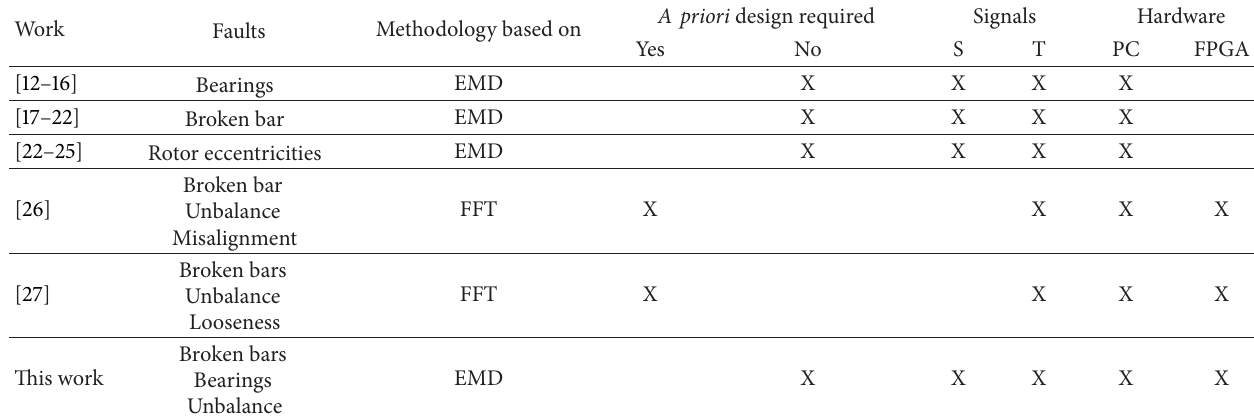
Table 5: Main characteristics of previous works and of the proposed